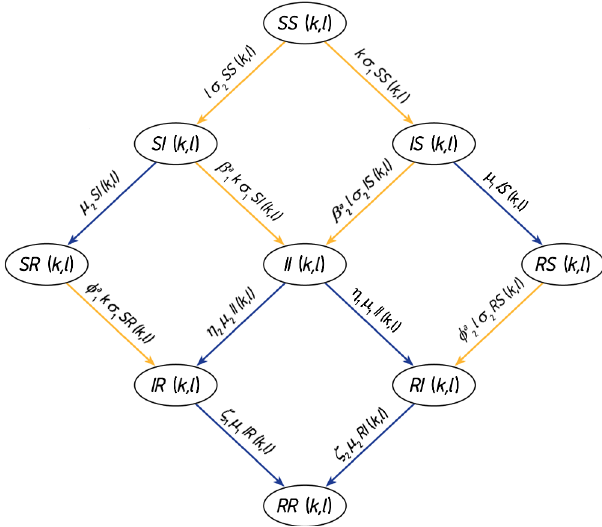
FIG. 7. Set of transitions allowed in the double SIR-SIR model. Yellow, contagion processes; blue, recovery processes.